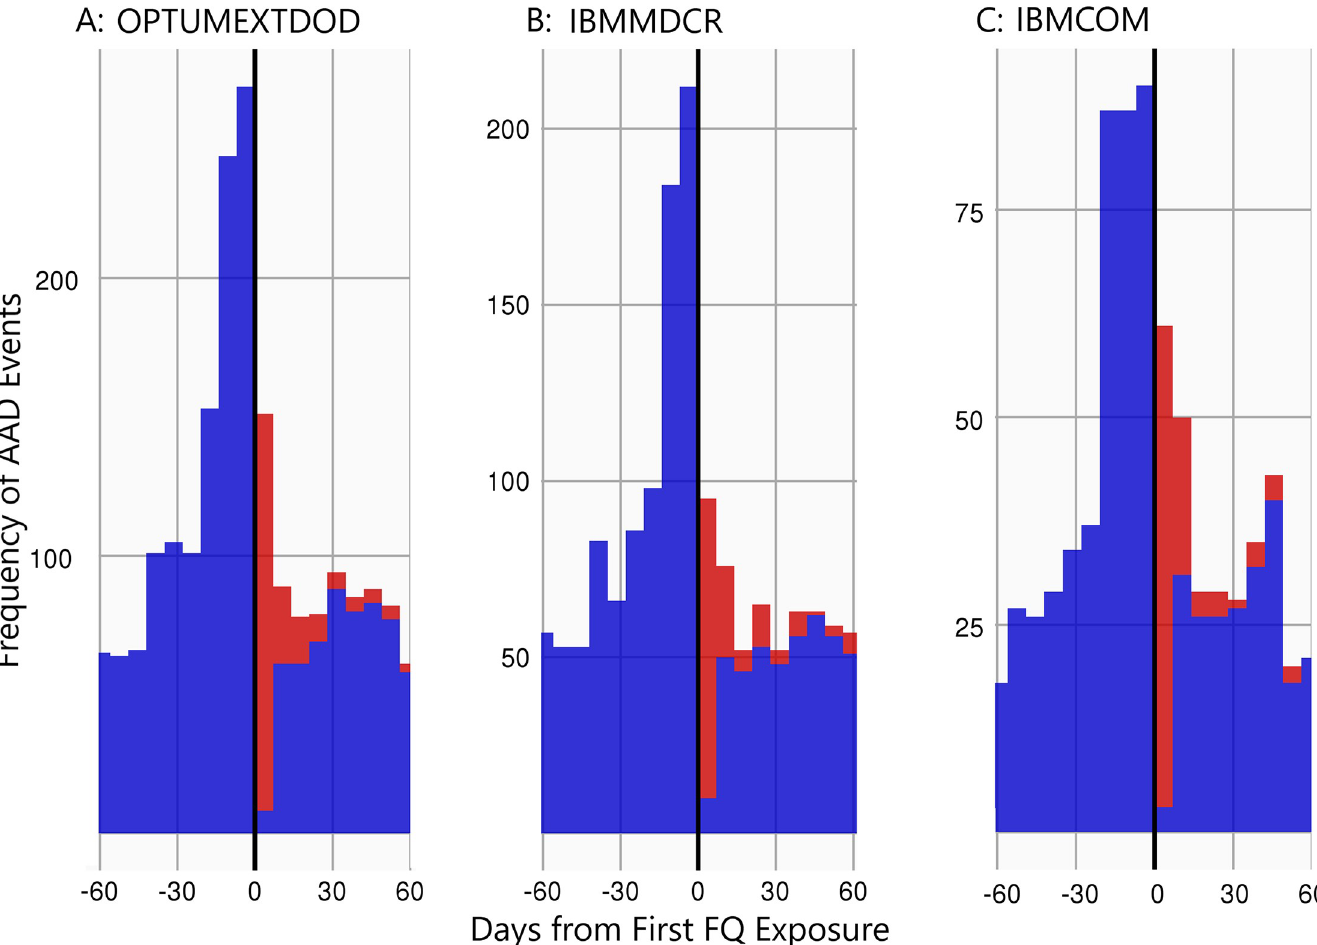
Fig 2. FQ exposure timeline vs AAD events in each database. A: Exposure timeline in OPTUMEXTDOD; B: Exposure timeline in IBMMDCR, C: Exposure timeline in IBMCOM. The exposure timeline figures present the frequency of AAD events (y-axis) over the 120-day period centered on the day of first exposure (x = 0). Red bars indicate that events occurred concurrently with the exposure window (i.e., days during antibiotics exposure, or FINTA, plus 30 days) whereas blue bars indicate events that occur outside of the risk window. A spike of events was observed prior to the first day of exposures to FQ.